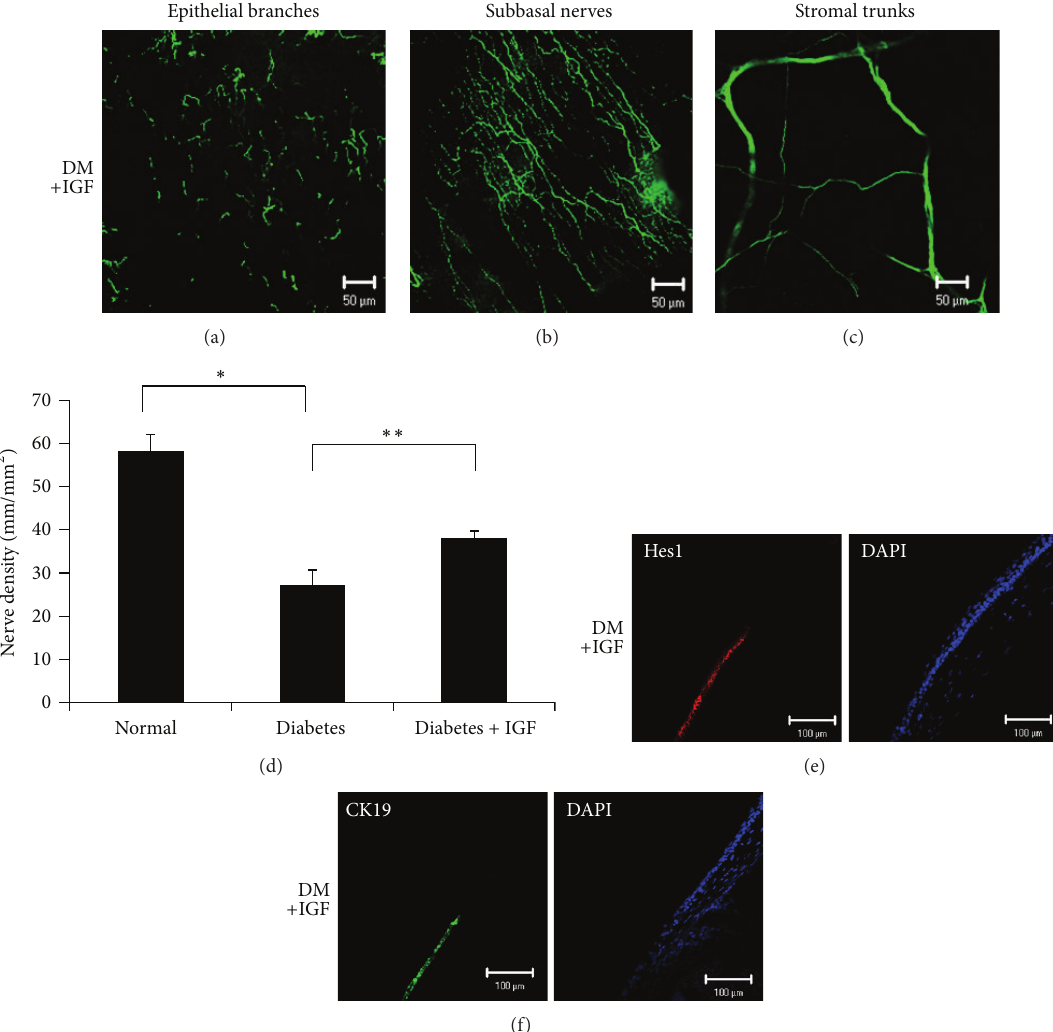
Figure4:Effectofdiabetesandtreatmentwithrecombinanthumaninsulin-likegrowthfactor-I(rhIGF-1)oncornealinnervationandcorneal progenitor/stem cells. Representative histological photomicrographs of corneal nerves that were immunostained with 𝛽 -III-tubulin showing epithelial nerve (a), the subbasal nerve plexus (b), and stromal nerve trunks. (c) The rhIGF-I administration significantly accelerated recovery of the corneal subbasal nerve and epithelial branches. (d) Histogram of the quantification of the corneal subbasal nerve density. The subbasal nerve plexuses of the diabetic eyes completely diminished compared with that in the normal eyes, whereas those of rhIGF-1-treated diabetic corneas recovered. Statistical comparison of data between groups was performed using the nonparametric Mann-Whitney U test. The bars represent the mean ± SEM ( ∗ 𝑃 < 0.00001 , ∗∗ 𝑃 < 0.01 ). Representative immunostained micrographs of cross-sections of diabetic and